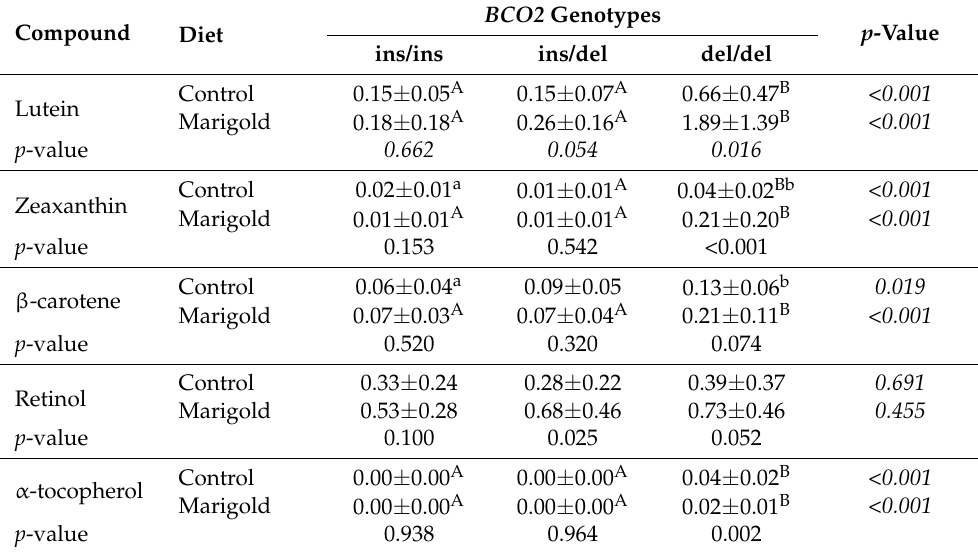
Table 2. Content of selected compounds in the brain ( µ g/g) of rabbits (mean ± SD).